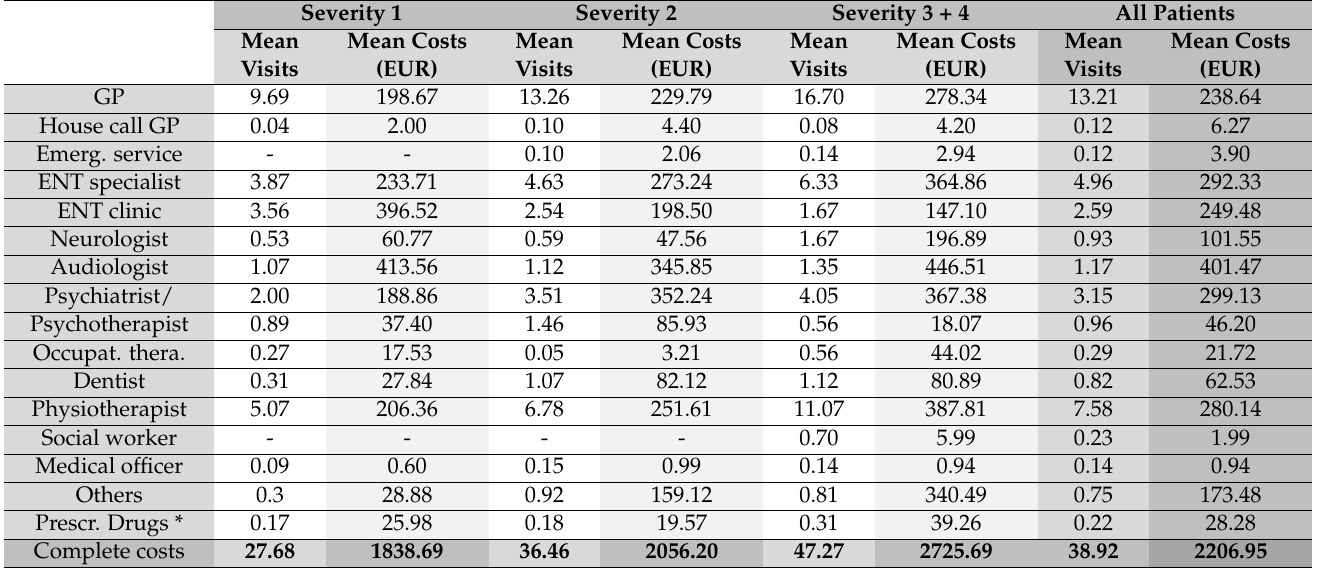
Table 3. Overview of mean costs for the health care system in one